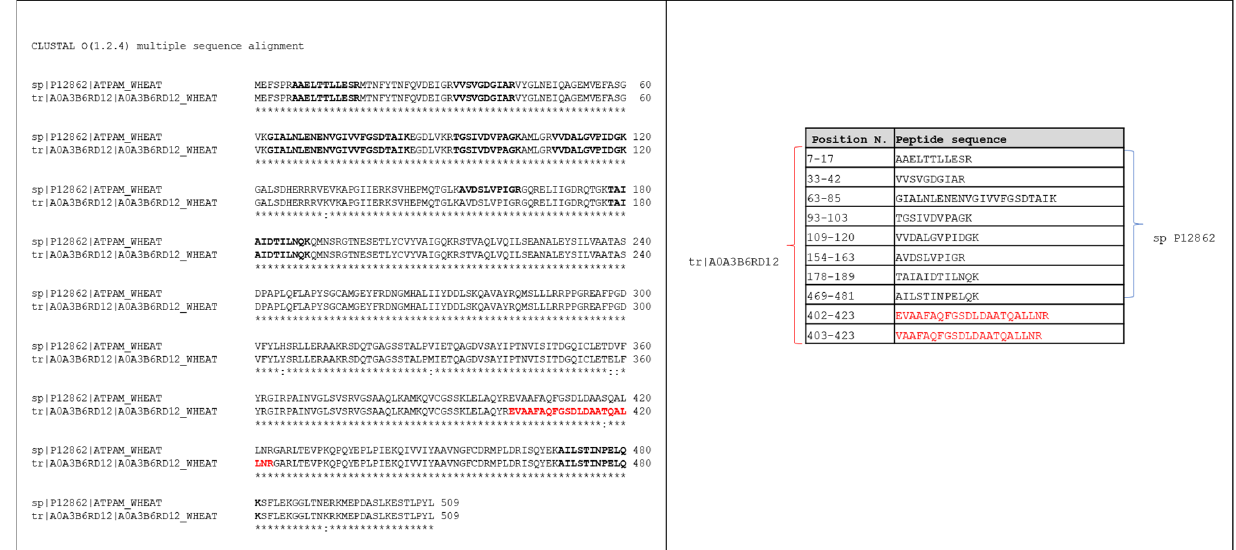
Figure 5. Alignment of the tr|A0A3B6RD12 and sp|P12862 entries. The characterized sequence traits are reported in bold (see also the table on the right). In bold red is the reported sequence trait 402–423 characterized by the identification of the two unique peptides (reported in red in the table on the right) related only to unreviewed entry tr|A0A3B6RD12.